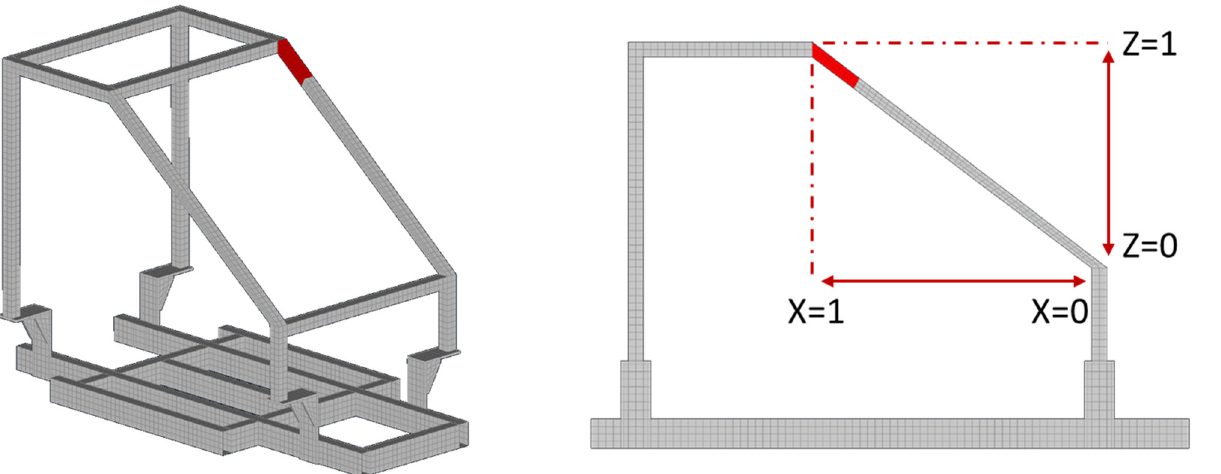
Figure 8. Damaged FE Model of Case 1.